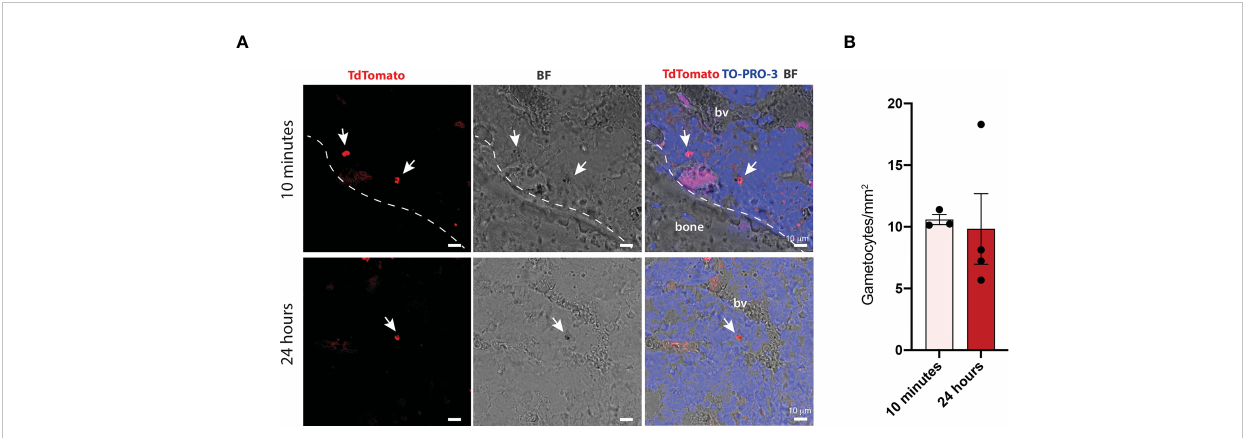
FIGURE 3 Quanti fi cation of P. falciparum stage II-III gametocytes within the bone marrow of chimeric ossicles (A) Confocal fl uorescent images showing stage II-III gametocytes in the bone marrow of ossicles harvested at 10 minutes and 24 hours post-injection (white arrows). White dotted line represents the boundary between the bone and the bone marrow. (B) Quanti fi cation of stage II-III gametocytes within bone marrow ossicles at the two different time points, each dot represents one ossicle. Ossicles derived from n=2 mice at 10 minutes and from n=2 mice at 24 hours. Data are presented as the mean ± SD. bv, blood